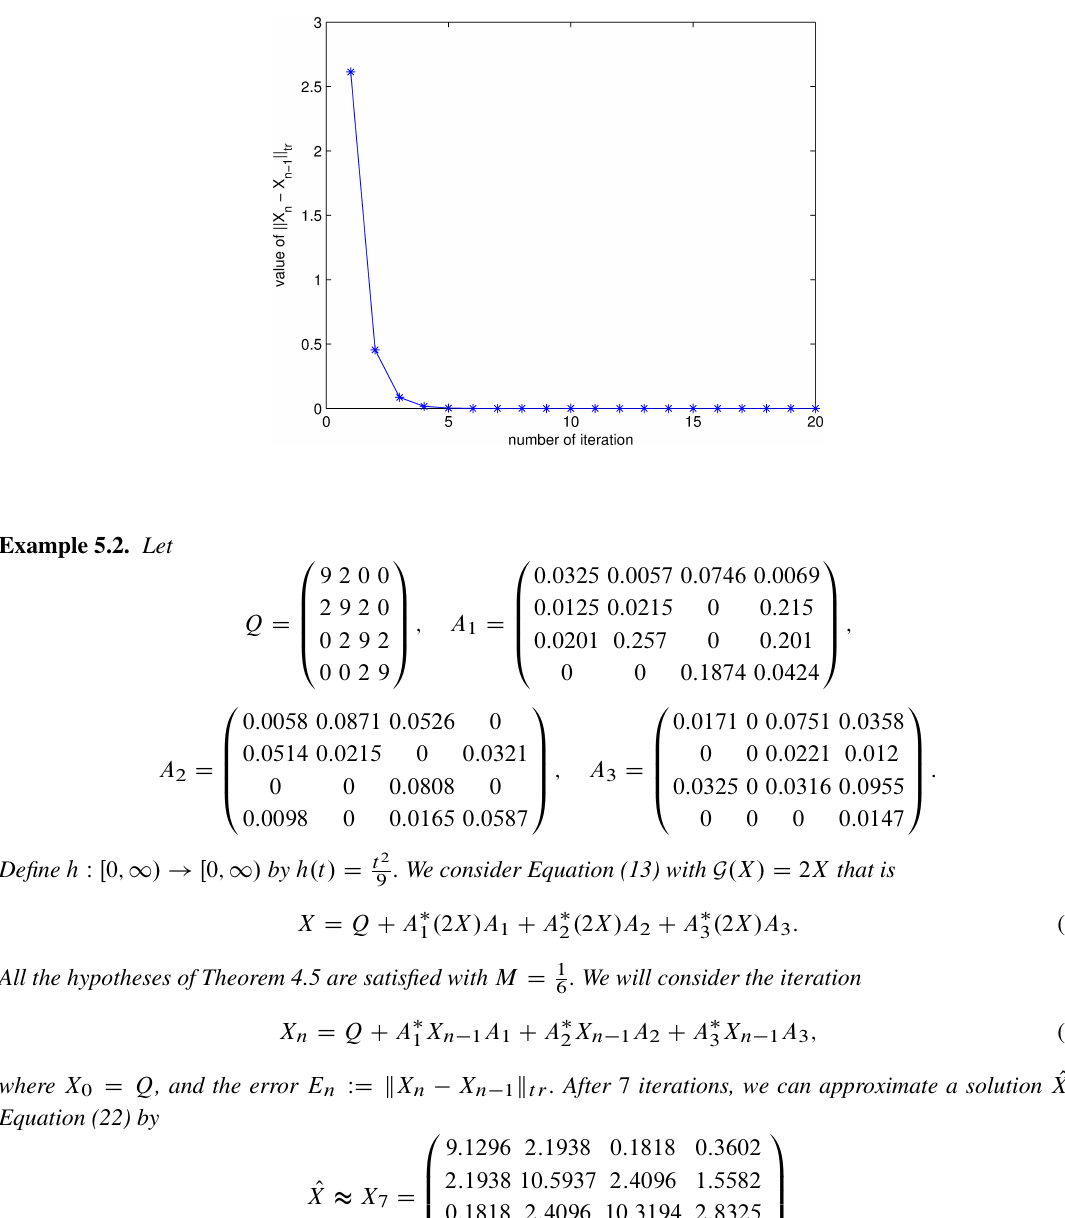
Fig. 3. The error of iteration process 21 for the Equation (20) given in Example